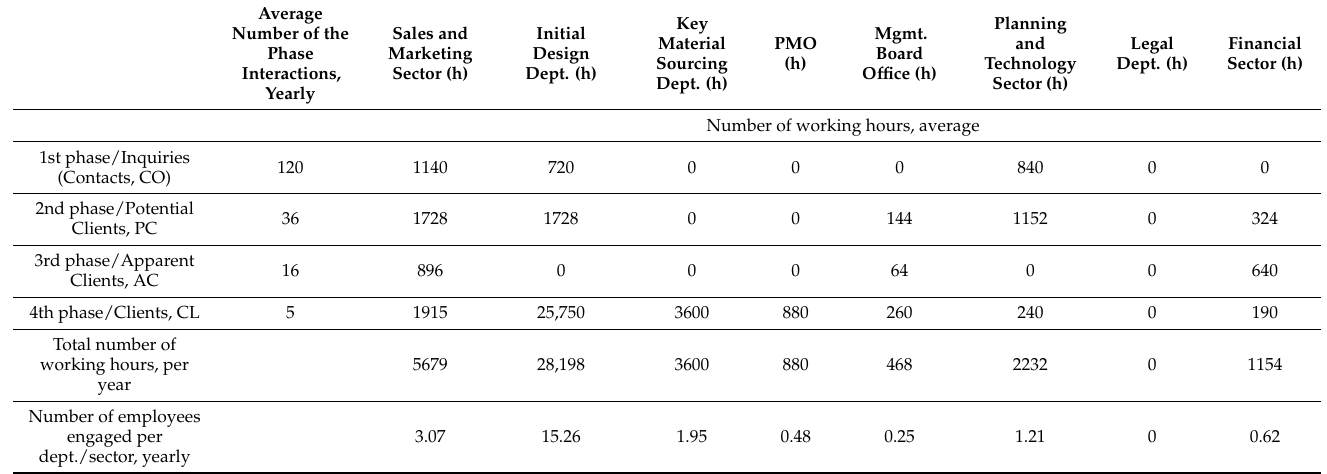
Table 3. The necessary number of employees in the sales process—annual average—future